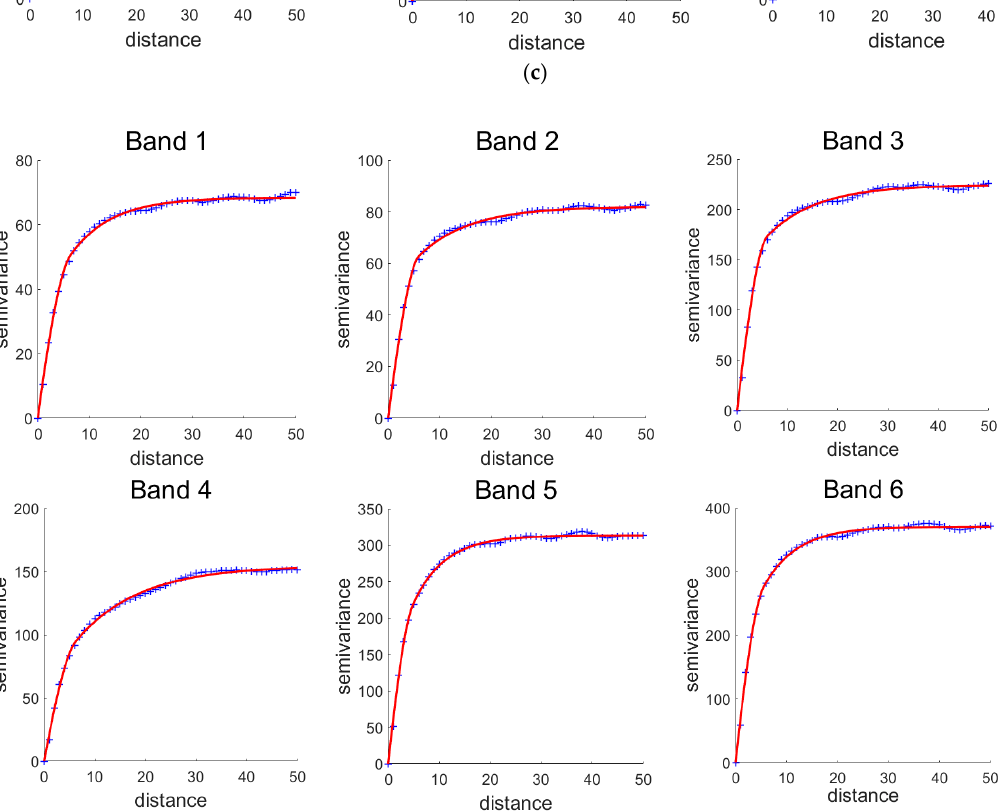
∼ Z (cid:48)(cid:48) ), ~ Z 6 1 1 ∼ Z (cid:48) ), and 6 1